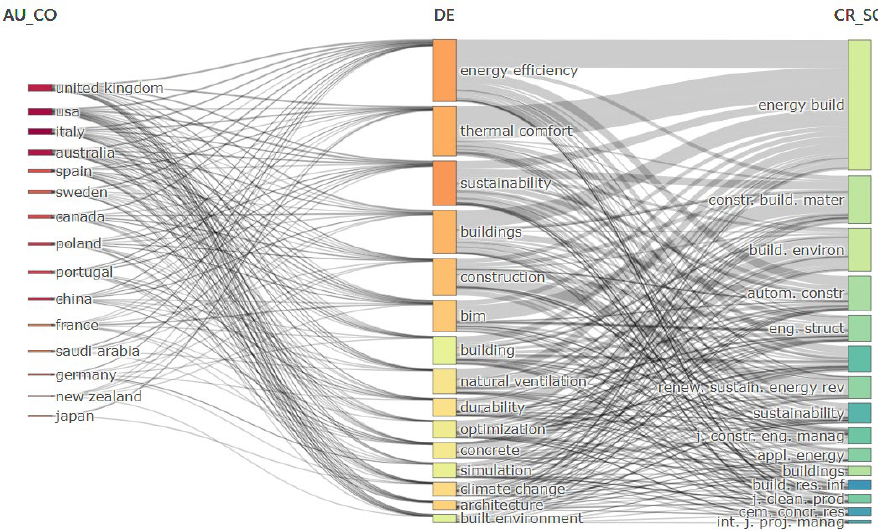
Figure 8. Three-fields plot.